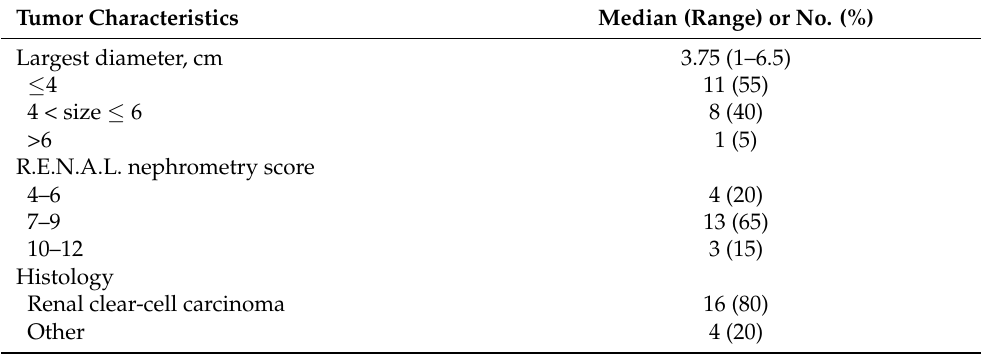
Table 2. Characteristics of the 20 malignant kidney tumors in the 19 patients included in the